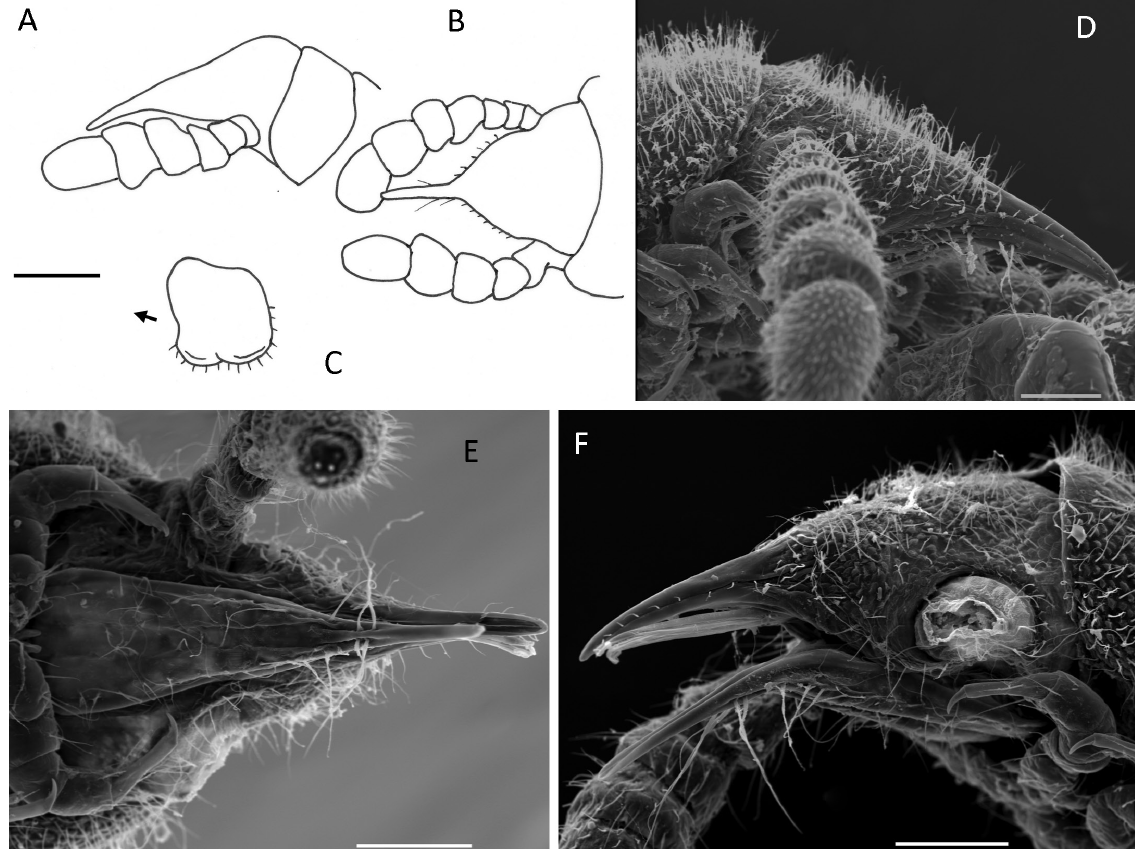
Fig. 3. Siphonophora setaepromissa sp. nov., non-type specimen. A . Head in lateral view. B . Head in dorsal view. C . Pleurite in lateral view, anterior to left. D . Head of male in lateral view. E . Head of female in ventral view. F . Head of female in lateral view with left antenna missing. Scale bars: A–C = 200 µm; D–F = 10